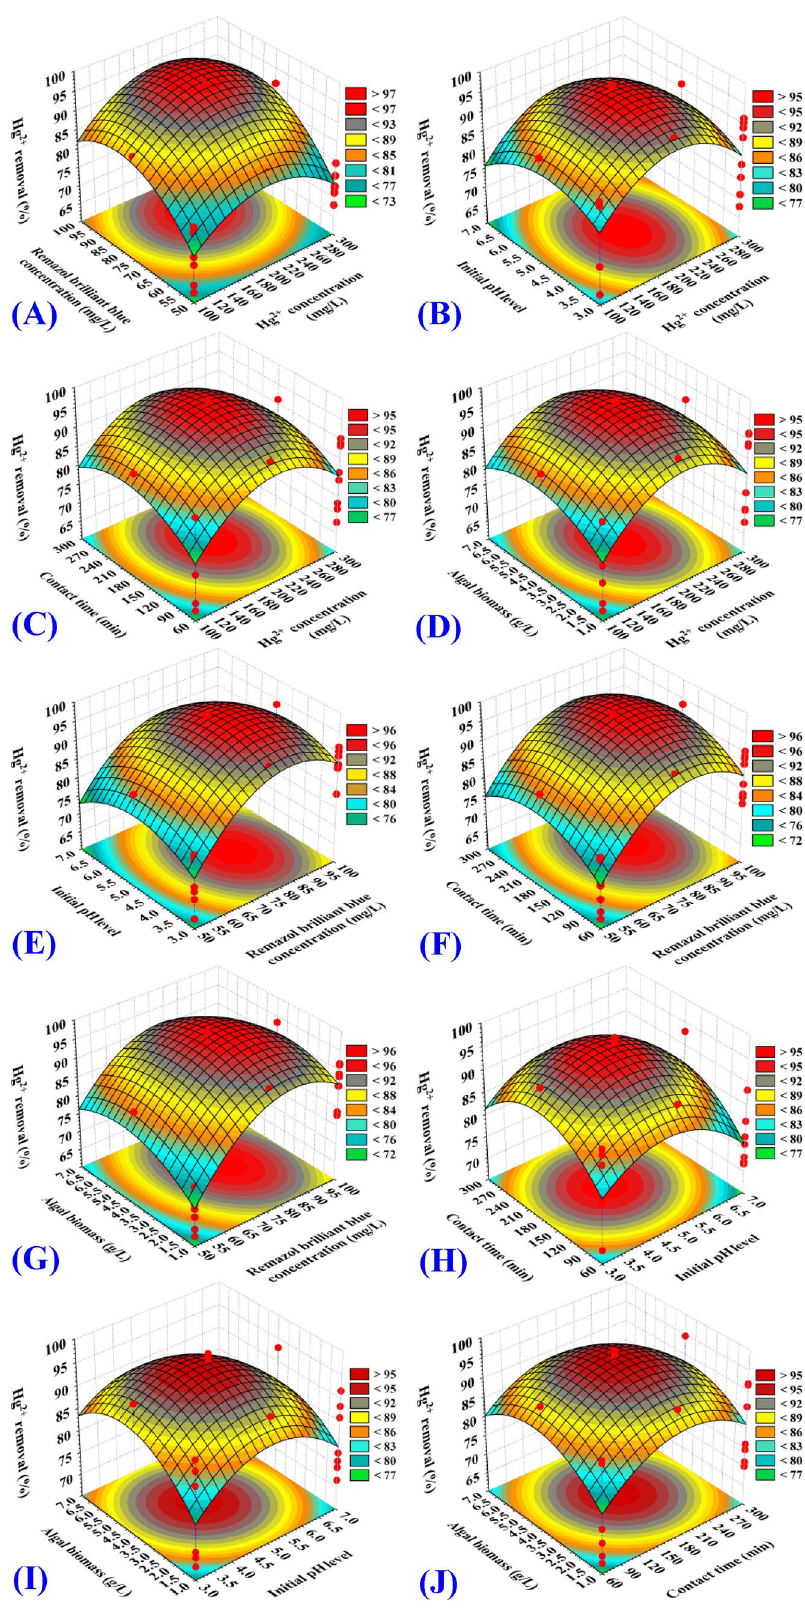
Figure 3. Three-dimensional surface plot for biosorption of Hg 2+ by Gelidium corneum biomass, showing the interactive effects of the five tested